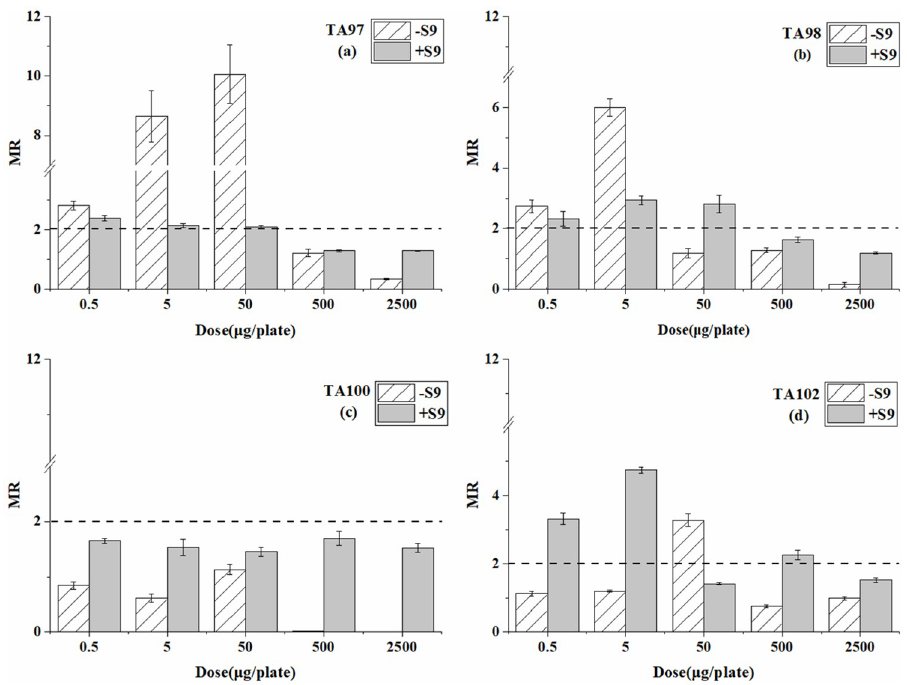
Fig 3. Mutagenesis of 4-MBC to four strains in the presence and absence of S9 liver extract; (a) TA97 strain; (b) TA98 strain; (c) TA100 strain; (d) TA102 strain. The mutation ratio (MR) is the average ratio ( ± SE) from three parallel